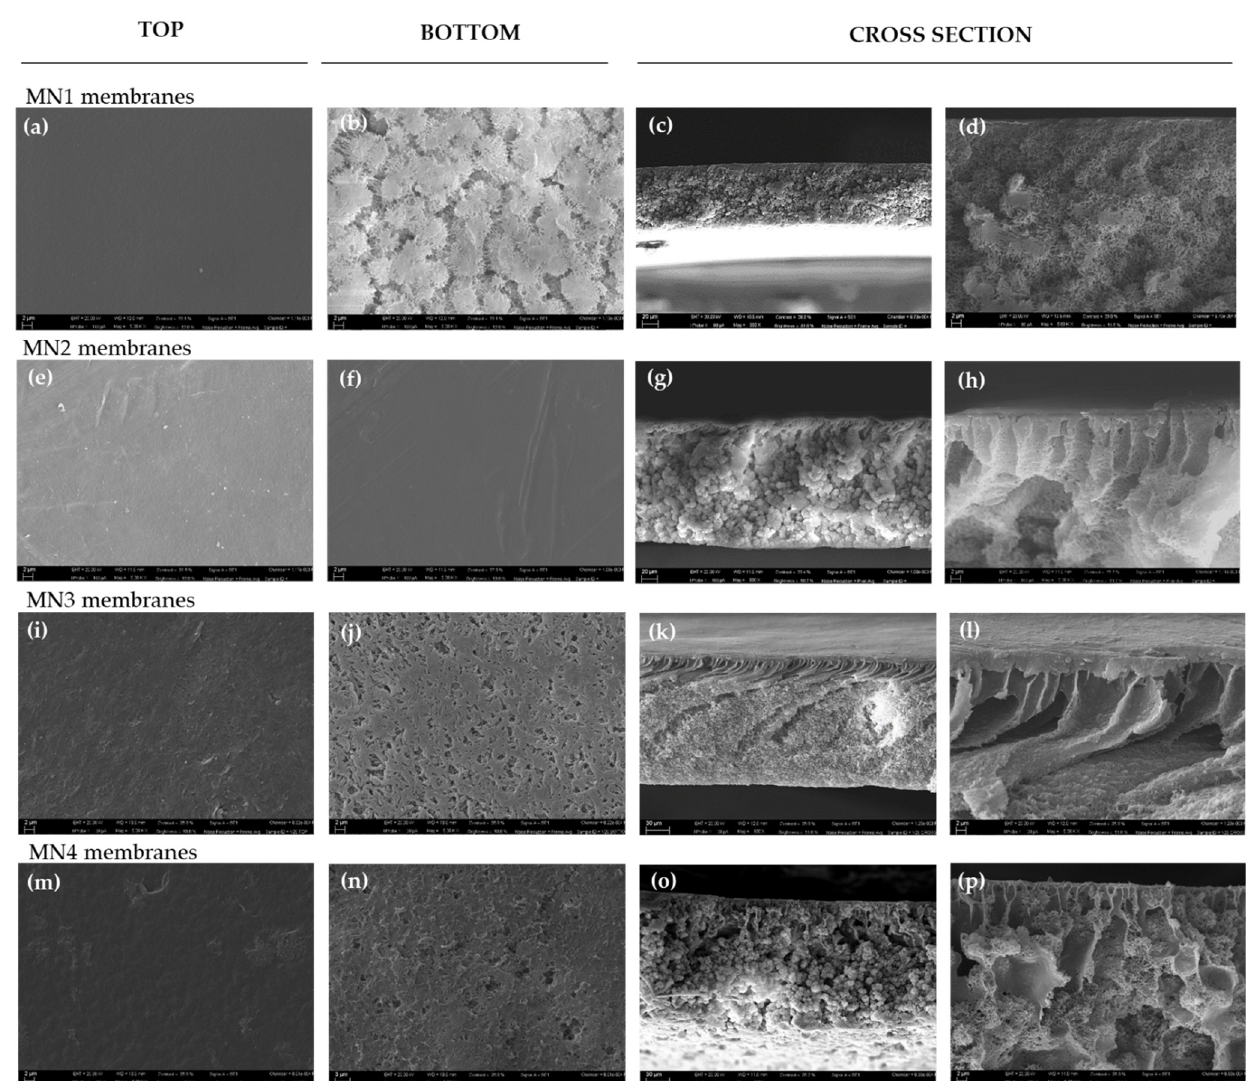
Figure 2. SEM pictures of prepared PVDF (15 wt%) membranes: ( a – d ) surface (top and bottom Mag. 5.00 KX) and cross-sections (Mag. 800 X and 5.00 KX) of the MN1, prepared without any additive; ( e – h ) surface (top and bottom Mag. 5.00 KX) and cross-sections (Mag. 800 X and 5.00 KX) of the MN2, prepared with PVP K17 (5 wt%); ( i – l ) surface (top and bottom Mag. 5.00 KX) and cross-sections (Mag. 800 X and 5.00 KX) of the MN3, prepared with PEG 200 (20 wt%) and ( m – p ) surface (top and bottom Mag. 5.00 KX) and cross-sections (Mag. 800 X and 5.00 KX) of the MN4, prepared with PEG 200 (40 wt%).